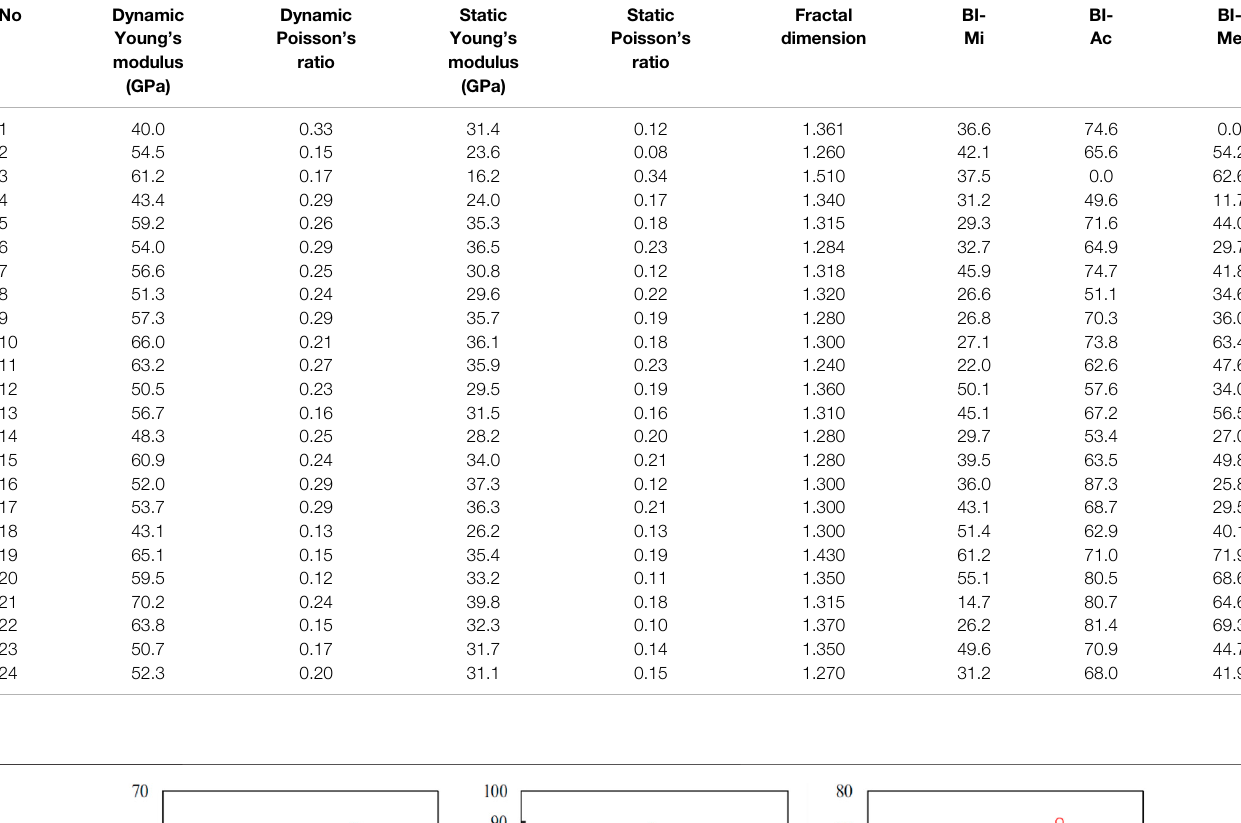
TABLE 3 | Calculated brittleness indices. No Dynamic Young ’ s